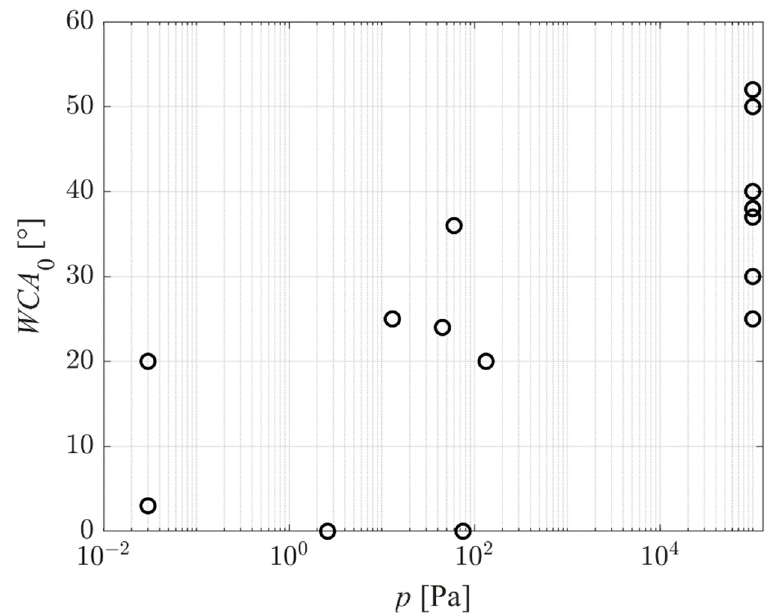
Figure 8. The WCA of as-treated PET samples (no aging) versus the pressure in the plasma chamber.